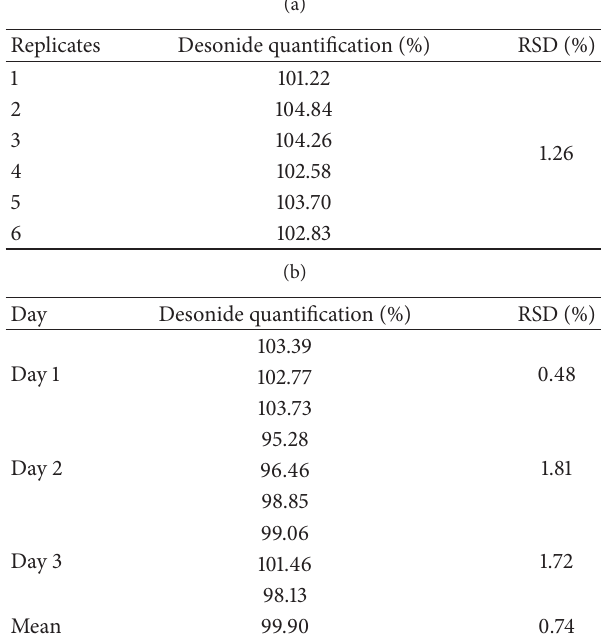
Table 2: (a) Values obtained from intraday precision for desonide quantification by HPLC. (b) Values for tests of the interday precision for 3 different